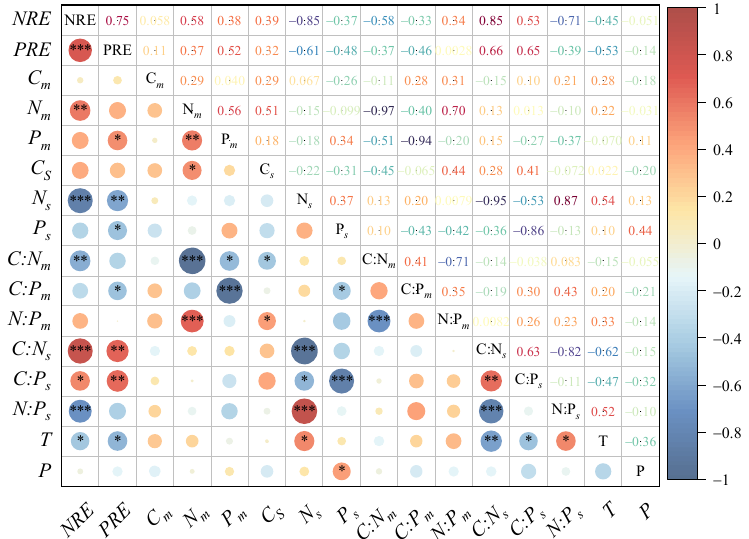
Figure 7. Correlation of nutrient contents, resorption efficiencies, and stoichiometric ratios with climatic factors in the Cunninghamia lanceolata plantation. Asterisks indicate significant correlations among indicators. * p < 0.05, ** p < 0.01, *** p < 0.001.